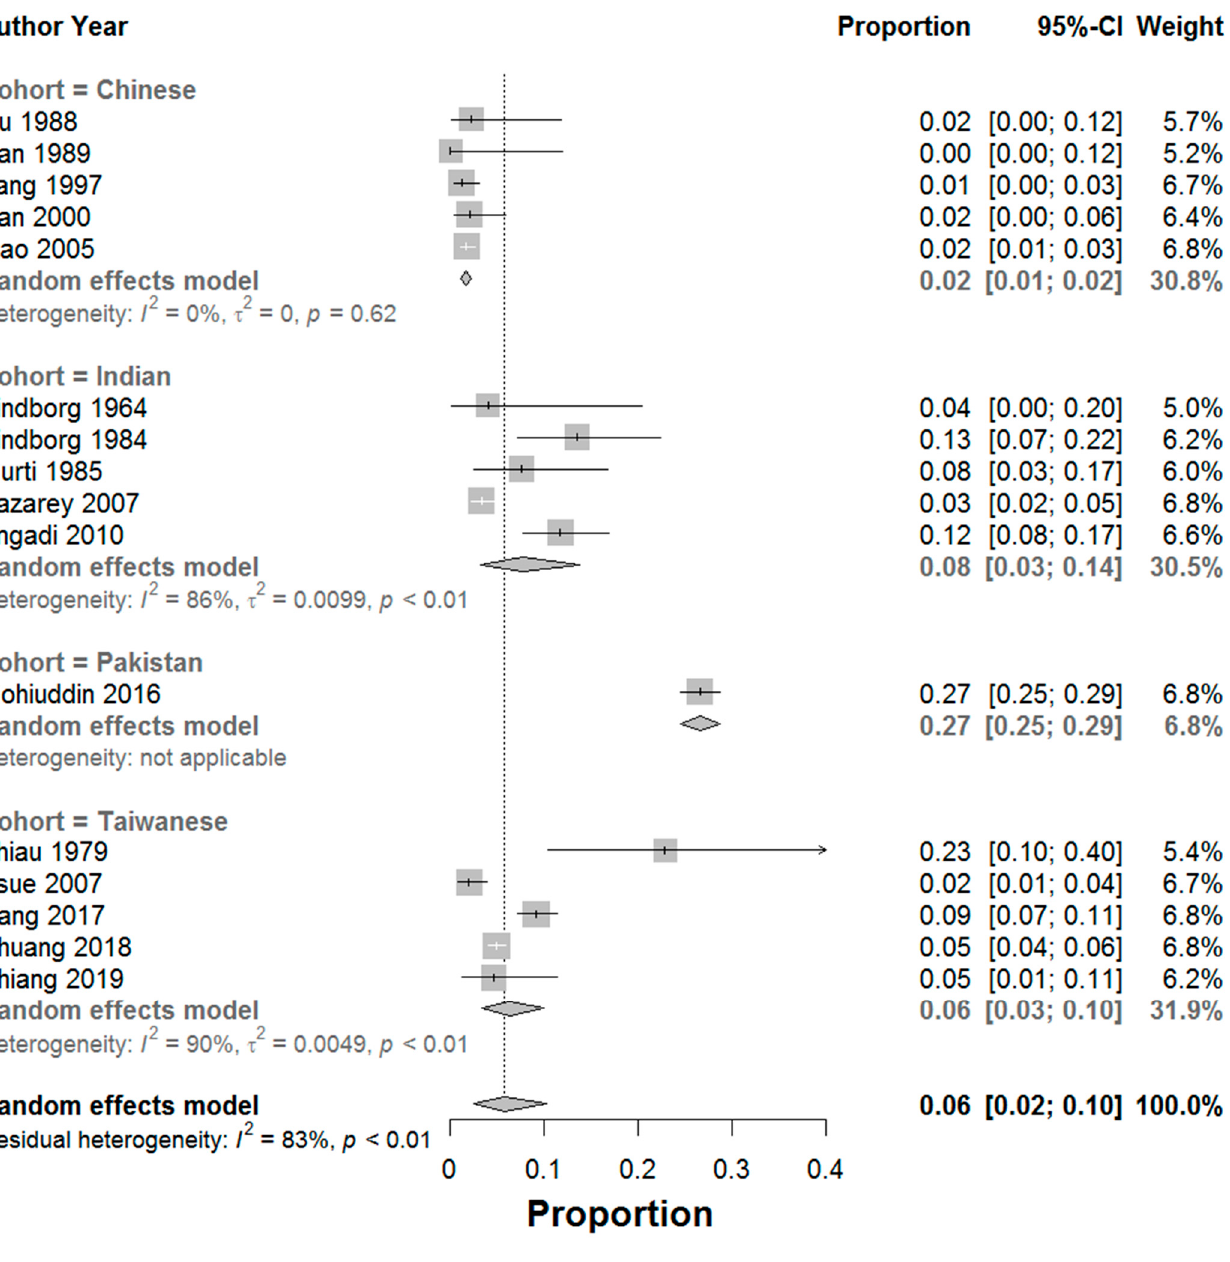
Figure 4. Forrest plot indicating the proportion of malignant transformation of OSF cases (95% confidence intervals) with weighting (%) attributed to each included case. Meta-analysis was per- formed on a subgroup basis (according to cohort ethnicity) and on an overall basis (including all data sets) [5,7–9,14–28].